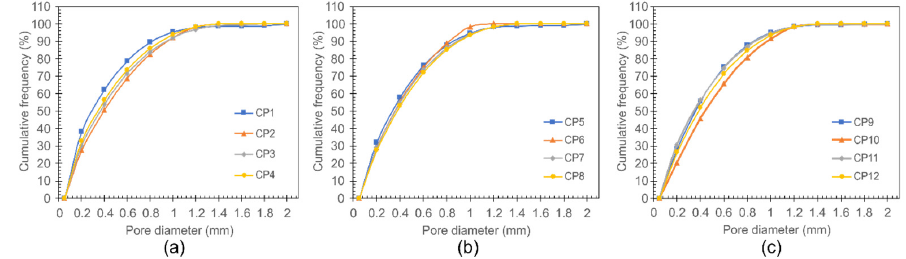
Figure 9. Cumulative frequency (%) as a function of average pore diameter for different amounts of foam. Granulometry: ( a ) fine; ( b ) medium and ( c ) coarse CDW.